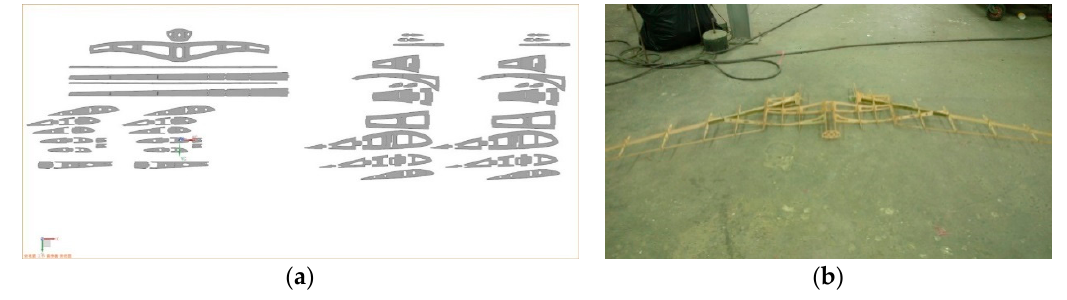
Figure 8. ( a ) Engineering drawing of ribs and ( b ) preassembly of ribs.